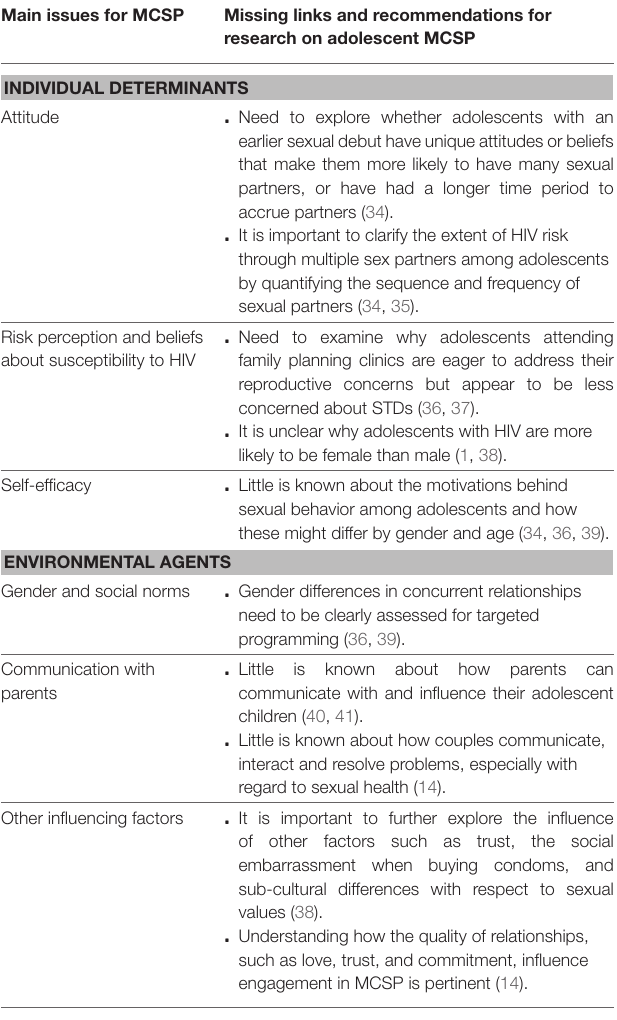
TABLE 3 | Missing links in the empirical literature and recommendations for further research on adolescent MCSP. Missing links and recommendations for research on adolescent MCSP INDIVIDUAL